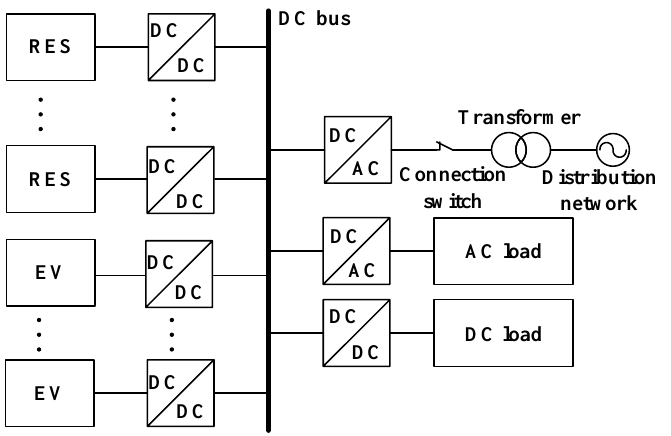
Figure 3. Structure of a DC microgrid.